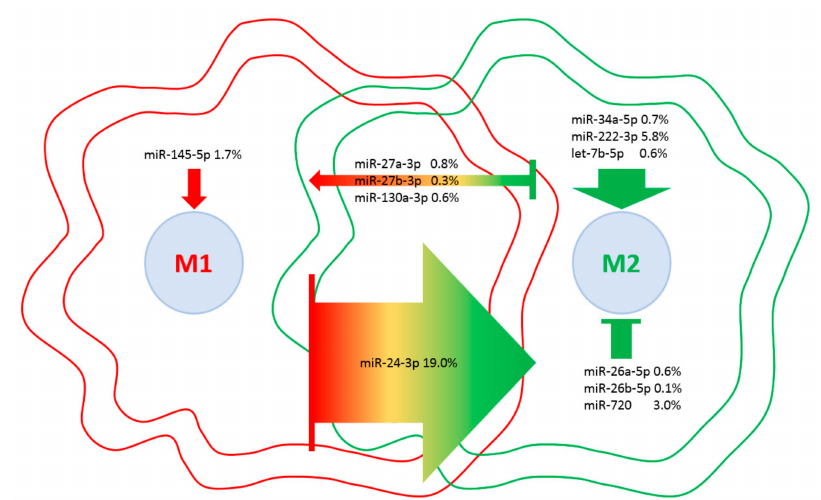
Figure 8. EV-miRNAs involved in M1 or M2 polarization in macrophages. Indication of miRNAs in the first quartile of expression in ASC-EVs and their role in macrophage polarization. miRNAs are divided per category, and the relative amount of their genetic message is shown. Direction of arrows represents the guidance of polarization phenotype. Size of arrows reflects the genetic